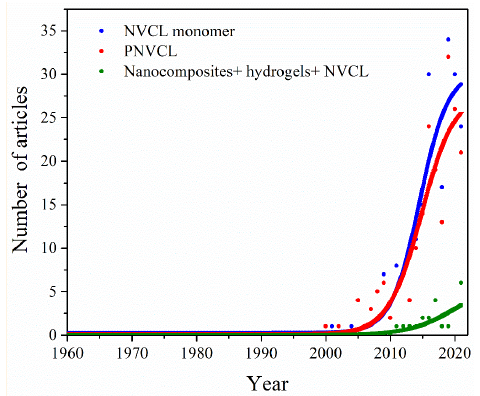
Figure 1. Curve indicating an increase in publications associated with the keywords: N -vinylcaprolactam, poly( N -vinylcaprolactam) and composites + hydrogel + N -vinylcaprolactam during the past 62 years.